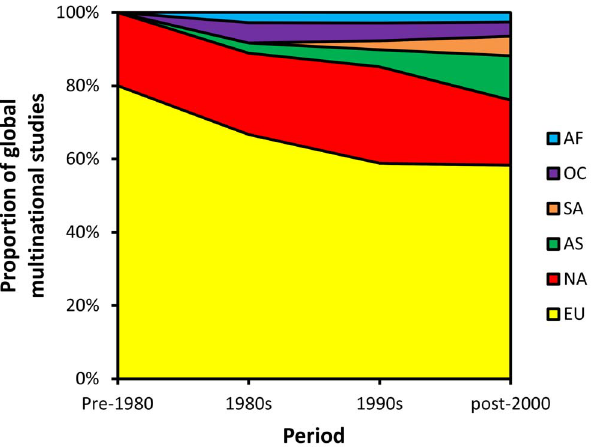
Fig. 3. Regional distribution of the proportion of all multinational clinical studies. AF, Africa. OC, Oceania. SA, South America. AS, Asia. NA, North America. EU,